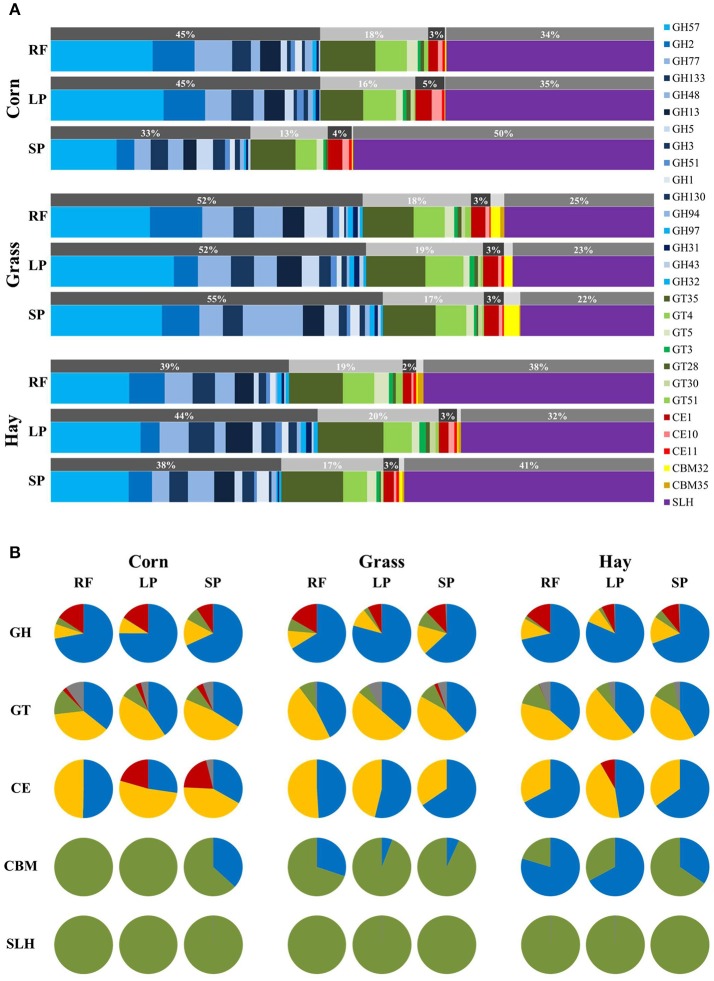
Abundance of 166 CAZymes in diets and sample fractions (n = 3). Glycoside hydrolases = GH (91 proteins), glycosyltransferases = GT (38 proteins), carbohydrate esterases = CE (16 proteins), carbohydrate-binding modules = CBM (2 proteins) and S-layer homology domains = SLH (19 proteins) (A). Pie charts depict the phylogenetic origin of CAZymes of the respective categories in diets and sample fractions at phyla level: blue, Bacteroidetes; green, Firmicutes; red, Proteobacteria; yellow, environmental samples; gray, others (B). RF, rumen fluid; LP, liquid phase; SP, solid phase.